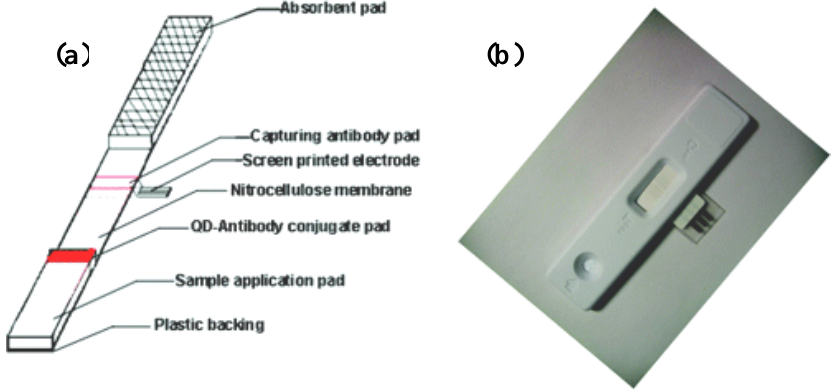
Figure 4. A schematic of the label-free electrochemical aptamer-based protein sensor. From Yi Xiao et al ., Angew. Chem. Int. Ed. 2005 , 44 , 5456-5459. Copyright Wiley-VCH